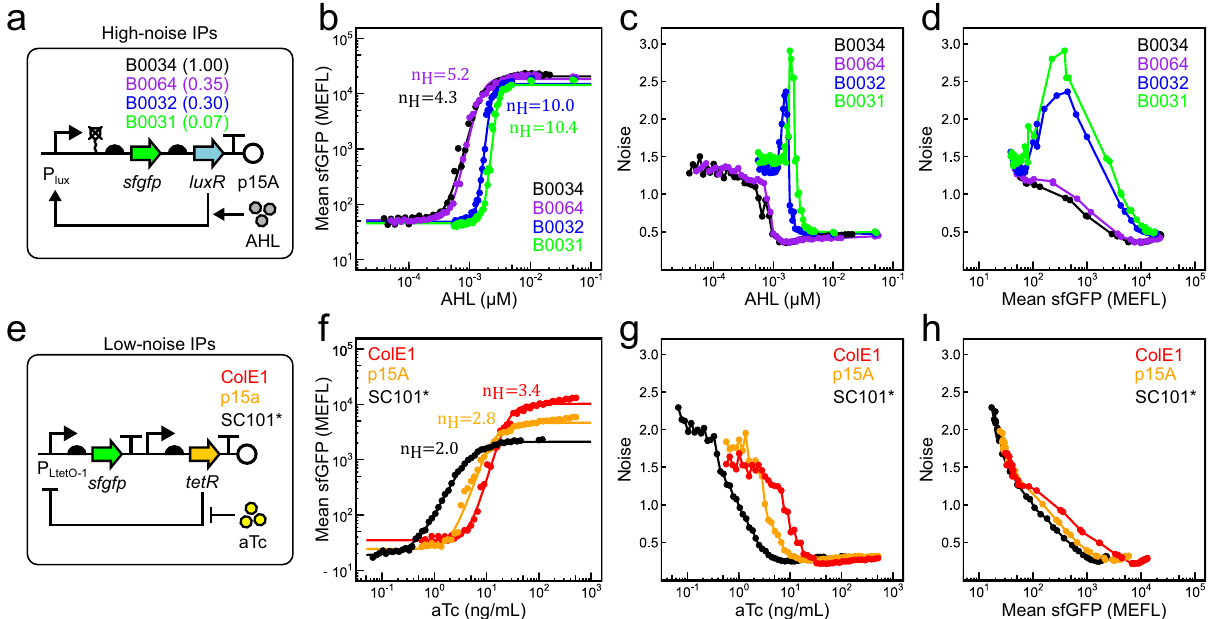
Fig. 2 Engineering low and high noise IPs controlled by AHL and aTc. a Library of high noise IPs based on LuxR-AHL-mediated positive transcriptional feedback. LuxR is encoded under RBSs of variable strength (indicated above the RBS) in different library members. Steady-state AHL-mean ( b ), AHL-noise ( c ), and mean-noise ( d ) transfer functions for high noise IP variants from a . e Library of low noise IPs based on TetR-aTc-inducible gene expression without feedback. Different plasmid origins on which this IP is introduced are indicated. Steady-state aTc-mean ( f ), aTc-noise ( g ), and mean-noise ( h ) transfer functions for origin of replication variants from e . Points within each group are single replicates collected from two separate experiments performed on 2 separate days. Smooth lines in b and f are fi ts to Hill functions with Hill coef fi cients ð n H Þ